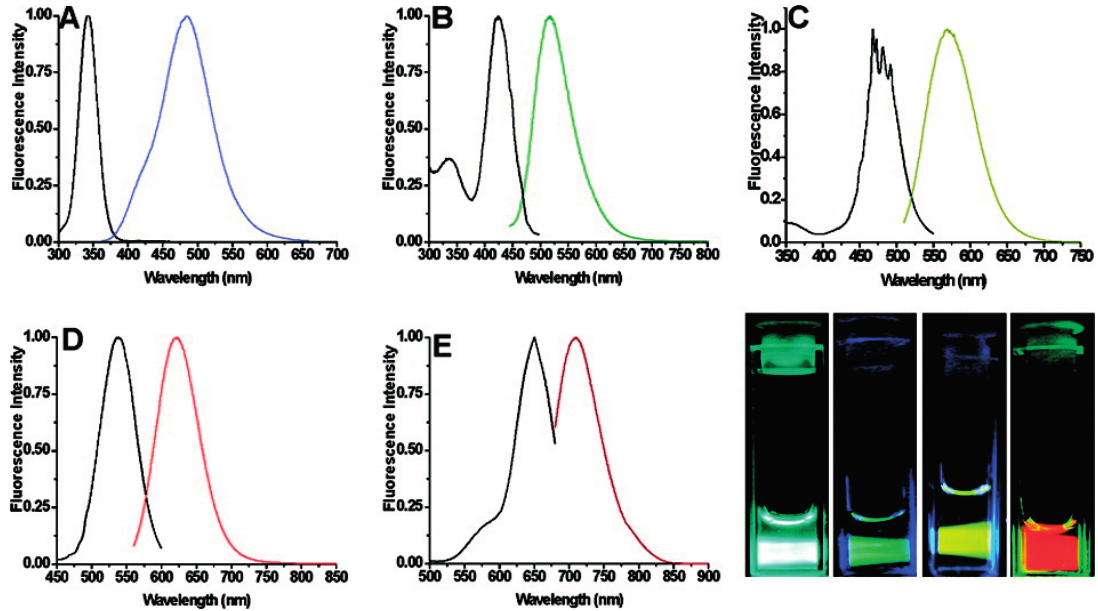
Figure 6. Excitation and emission spectra for ss-DNA encapsulated AgNCs. ( A ) Blue Emitters (5'-CCCTTTAACCCC-3') ( B ) Green Emitters (5'-CCCTCTTAACCC-3') ( C ) Yellow Emitters (5'-CCCTTAATCCCC-3') ( D ) Red Emitters (5'-CCTCCTTCCTCC-3') ( E ) near-IR emitters (5'-CCCTAACTCCCC-3') ( F ) Images of solutions A–D [140]. Reprinted with permission from [140]. Copyright 2014 American Chemical